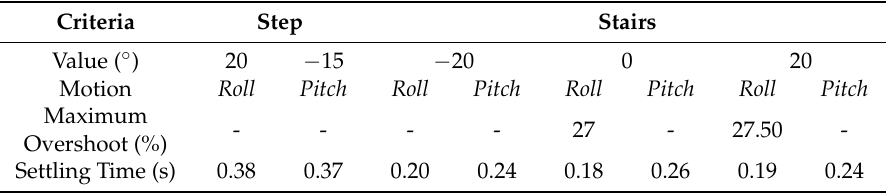
Figure 18. Roll and pitch motions together: ( a ) Step response; ( b ) Stairs response. Table 2. The simultaneously closed loop control performance of the roll and pitch motions for step and stairs